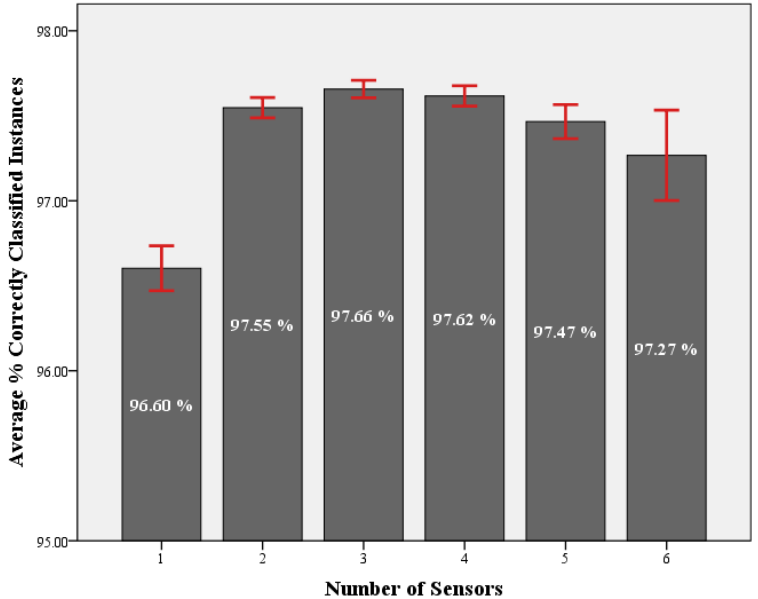
Figure 3. Graph presents the average percentage of correctly classified instances for each number of sensor combinations. The average for each number of sensors is labeled. Error bars represent 95% confidence